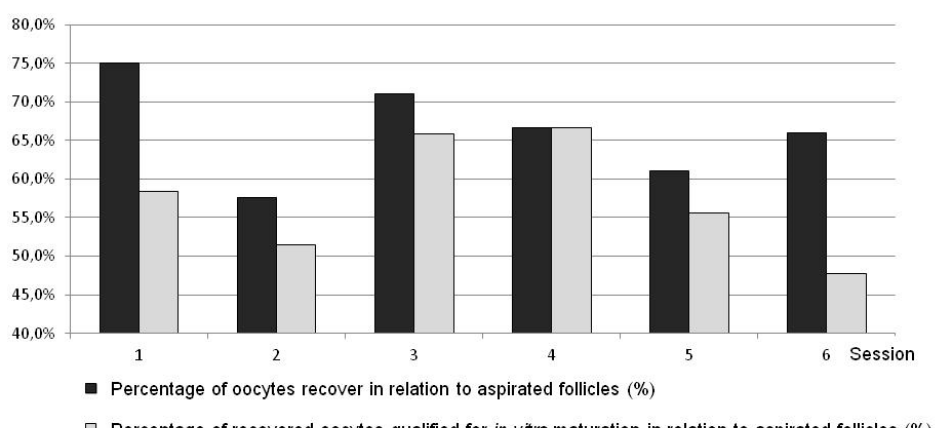
Figure 7. Comparing various L-OPU sessions with respect to percentages of recovered oocytes and oocytes selected for IVM in sheep.